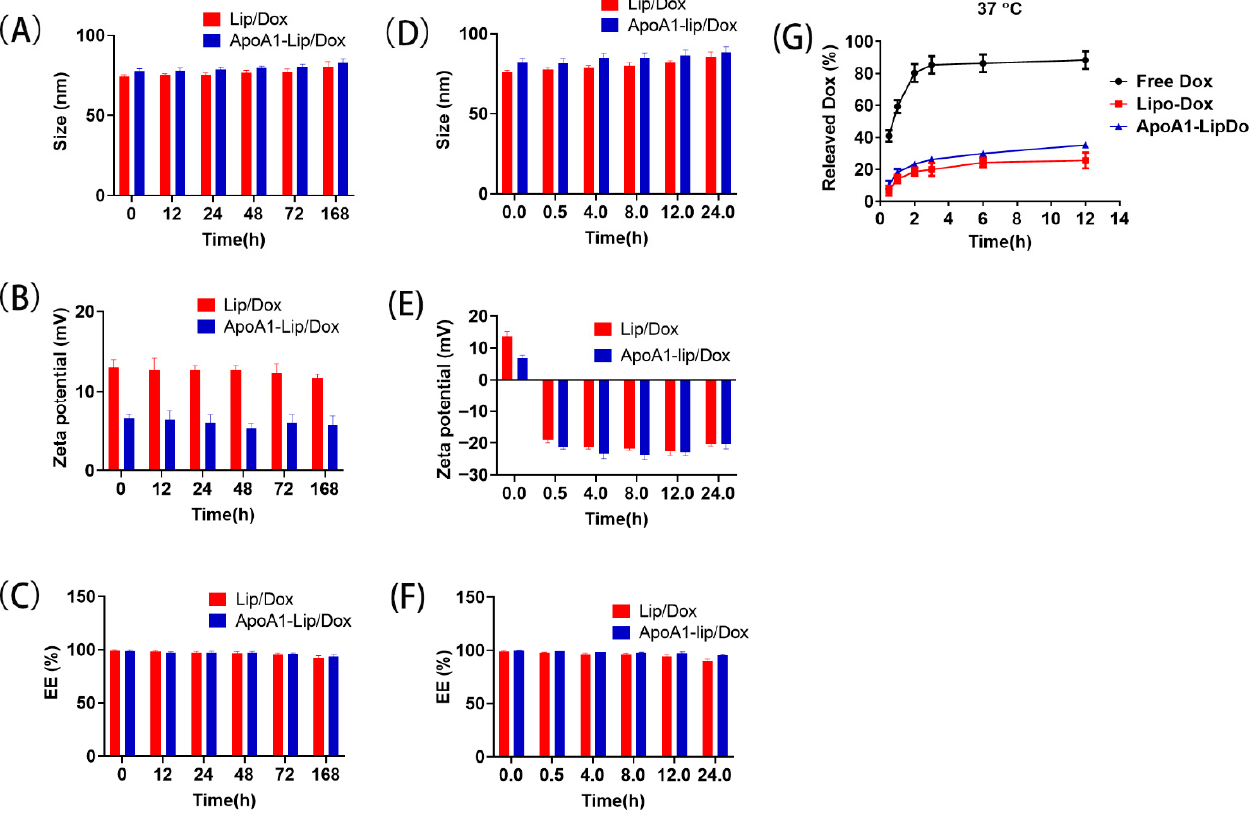
Figure 2. Stability of Lip/Dox and ApoA1-lip/Dox. Size distribution ( A ), zeta potential ( B ), and encapsulation efficiency ( C ) of Lip/Dox and ApoA1-lip/Dox stored at 4 °C for 168 h. Size distribution ( D ), zeta potential ( E ), and encapsulation efficiency ( F ) of Lip/Dox and ApoA1-lip/Dox cultivated in serum at 37 °C for 24 h. ( G ) The release profiles of Dox from free Dox, Lip/Dox, and ApoA1-lip/Dox at pH 7.4 PBS.